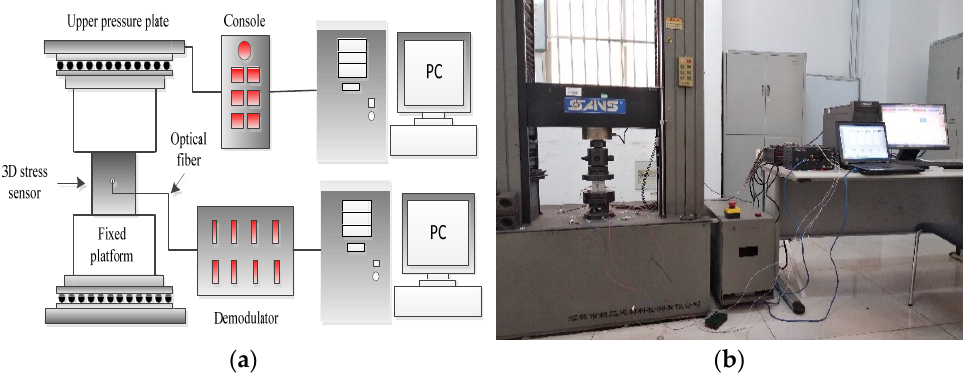
( f ) Figure 10. Axial strain distribution of each optical fiber under 50 MPa hydrostatic pressure (The value on the graph is ε ). ( a ) Strain of optical fiber 1; ( b ) Strain of optical fiber 2; ( c ) Strain of optical fiber 3; ( d ) Strain of optical fiber 4; ( e ) Strain of optical fiber 5; ( f ) Strain of optical fiber 6. By inserting the Path into the model, the measured strain value at the center of each fiber is the fiber grating strain. Under 50 MPA of hydrostatic pressure, the strains of fiber gratings are 334.79, 334.26, 334.73, 333.82, 334.08 and 333.87 με , respectively. From Equa- tion (13), the triaxial pressures of model X , Y and Z can be calculated to be 49.9918 MPa, 49.9908 MPa and 49.9898 MPa, respectively. It can be seen that the calculated value of this model is slightly smaller than the theoretical value but the error is less than 1%, which meets the accuracy requirements of the three-dimensional stress monitoring of the sur- rounding rock. 4. Sensor Experiments and Analysis of Results 4.1. Sensor Experiment System